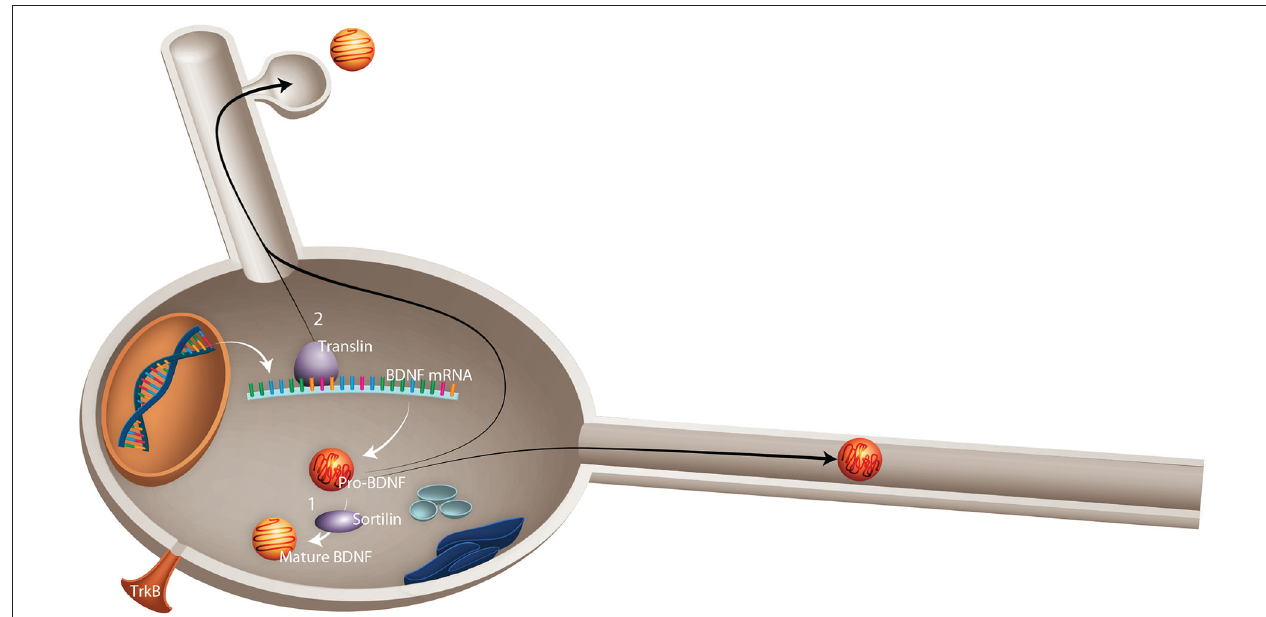
secretory pathway instead of activity-dependent release. (2) Translin is a highly conserved protein involved in mRNA transport. An exon found in all BDNF mRNA splice variants contains a specific translin-binding region, which is essential for appropriate BDNF mRNA dendritic targeting. It has been shown that val66met substitution diminishes BDNF mRNA interaction with translin, which leads to reduced translocation of BDNF mRNA to dendrites (Published from Sanchez et al.,